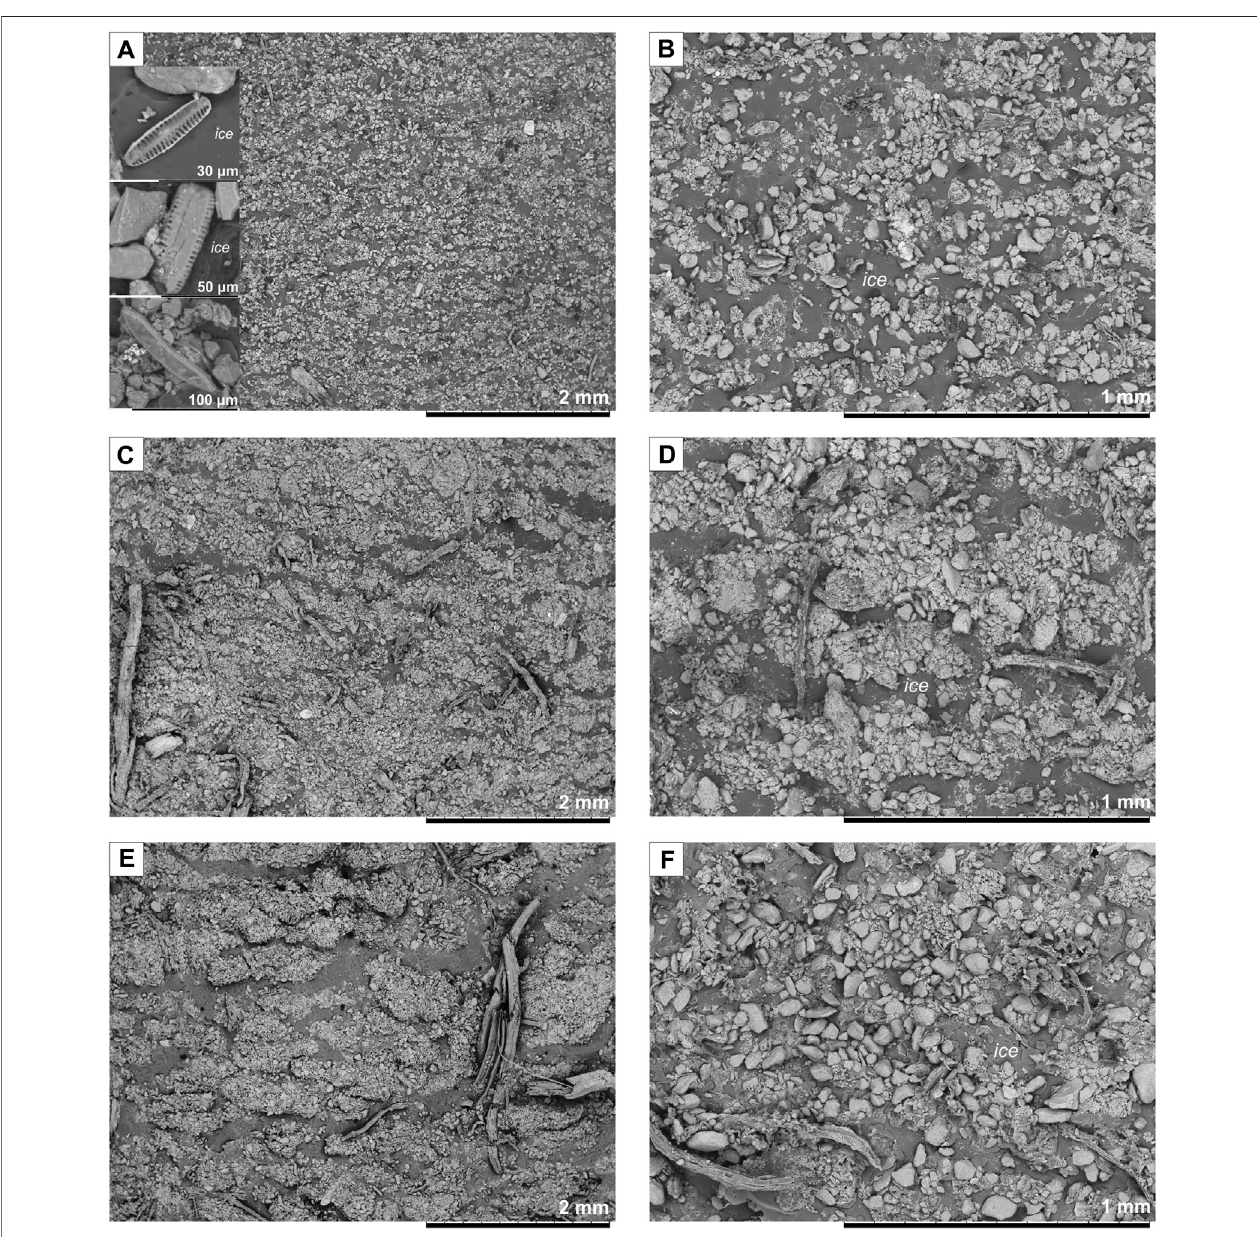
FIGURE 2 | Microstructure of Ice Complex deposits: (A,B) latent lenticular microstructure, Zelyony Mys site, sampled at 35 m arl; (C,D) braided microstructure, Plakhinskii Yar site, sampled at 12 m arl; (E,F) irregular reticulate microstructure, Kolymskoe site, sampled at 25 m arl. arl (cid:2) above river level.